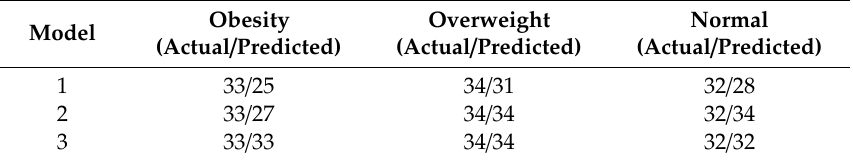
Table 6. The classification results of the models in the 1 KHz frequency band.